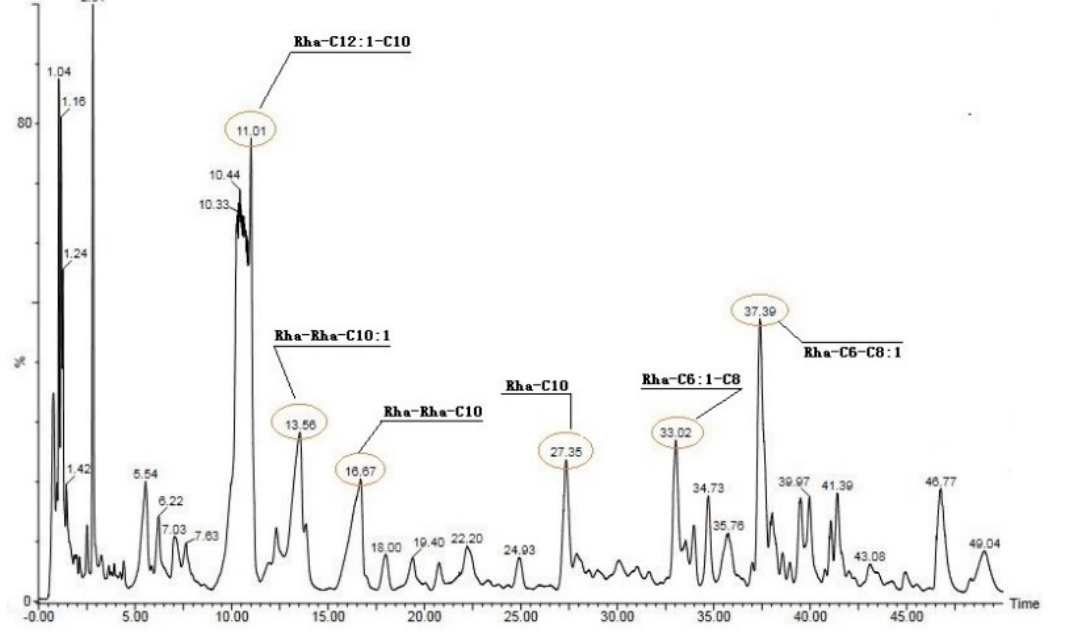
Figure 6. HPLC ‐ MS analysis of Pa secretion. Figure 6. HPLC-MS analysis of Pa